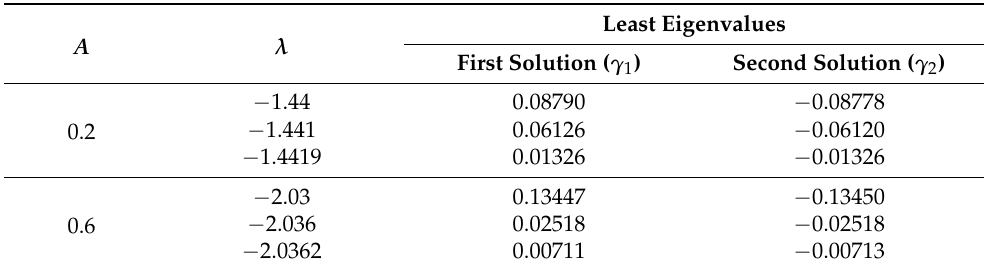
Table 4. The least eigenvalues for preferred values of A and λ as S = 2.4, φ s 2 = 0.01, B = 0.2 and β =